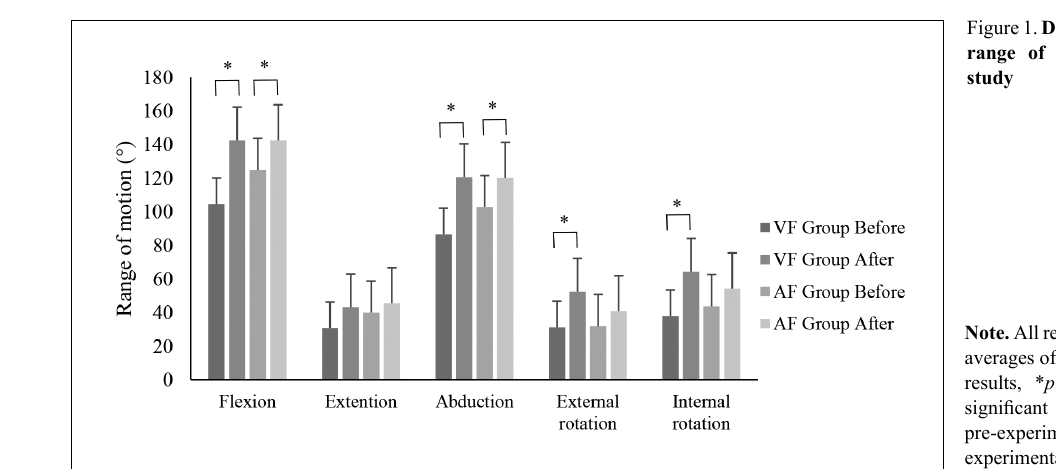
Figure 1. Difference in